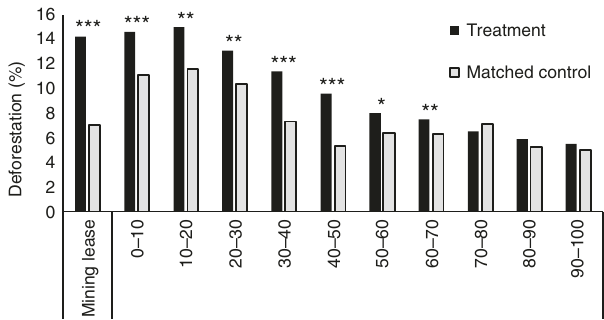
Fig. 2 Deforestation rates within treatments and matched